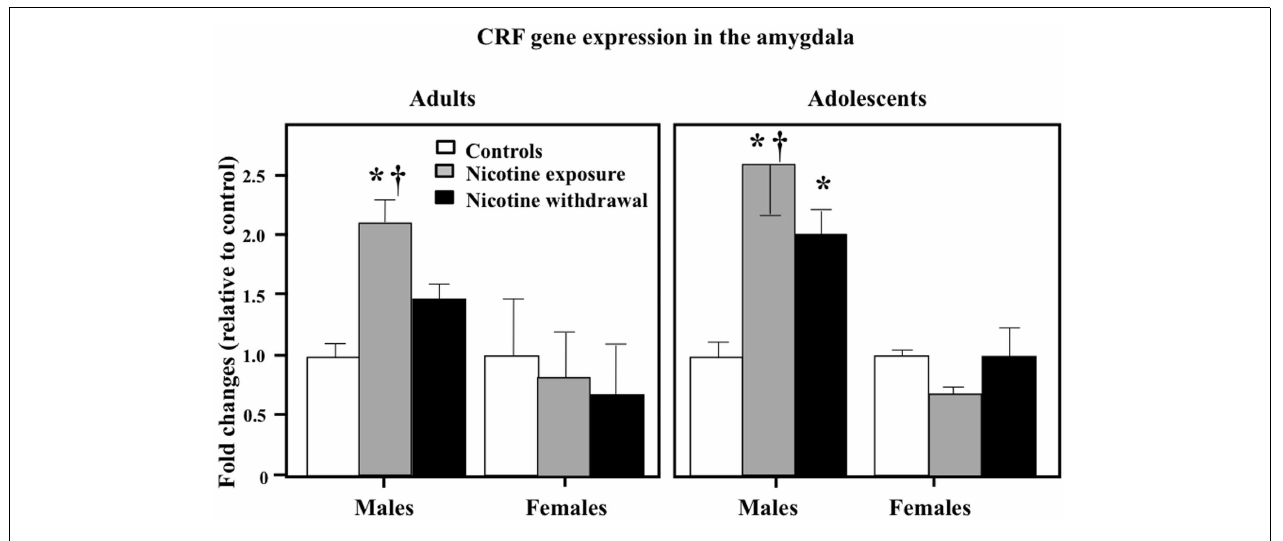
(control n = 4; nicotine exposure n = 6; nicotine withdrawal n = 4), and adolescent female (control n = 4; nicotine exposure n = 4; nicotine withdrawal n = 4) rats .The asterisks (*) denote a significant difference between nicotine-treated rats and their respective male controls ( P < 0.05).